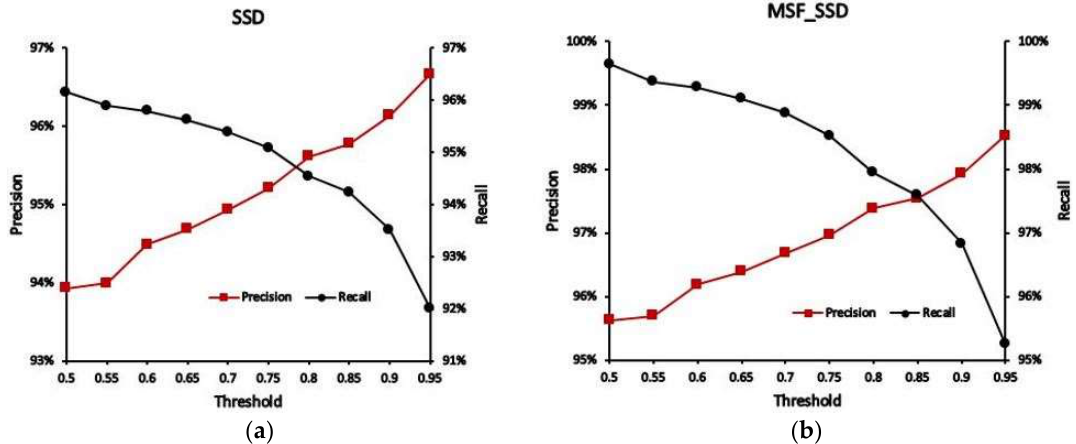
Figure 11. Performance of MSF_SSD and SSD with different threshold: ( a ) Trend of precision and recall of SSD given threshold; ( b ) Trend of precision and recall of MSF_SSD given